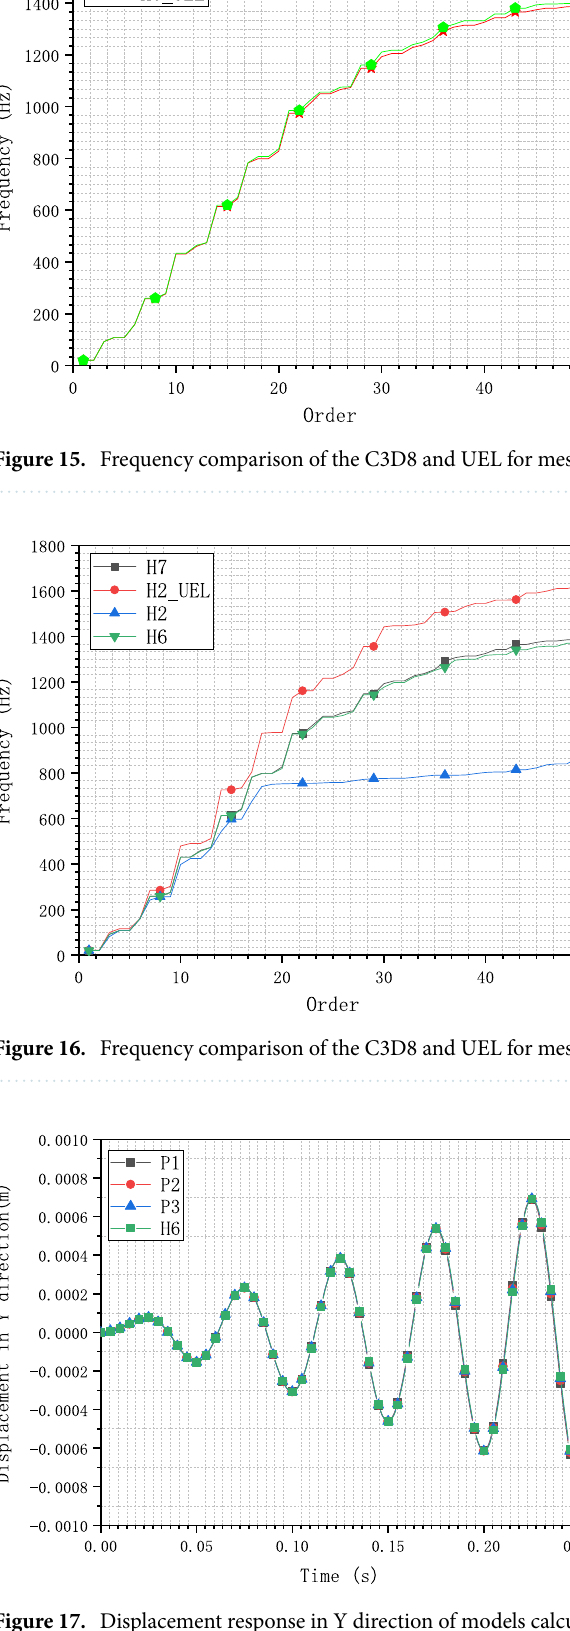
Figure 17. Displacement response in Y direction of models calculated by C3D8 and